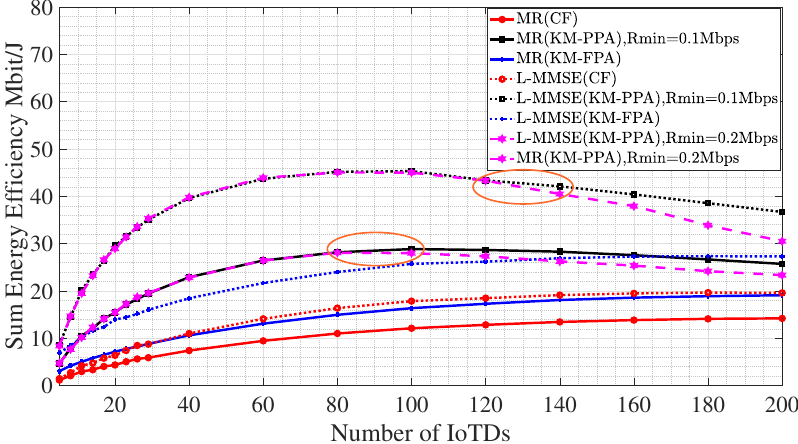
Figure 5. The sum energy efficiency versus the number of IoT devices (IoTDs), access points (APs) equipped with single antenna.